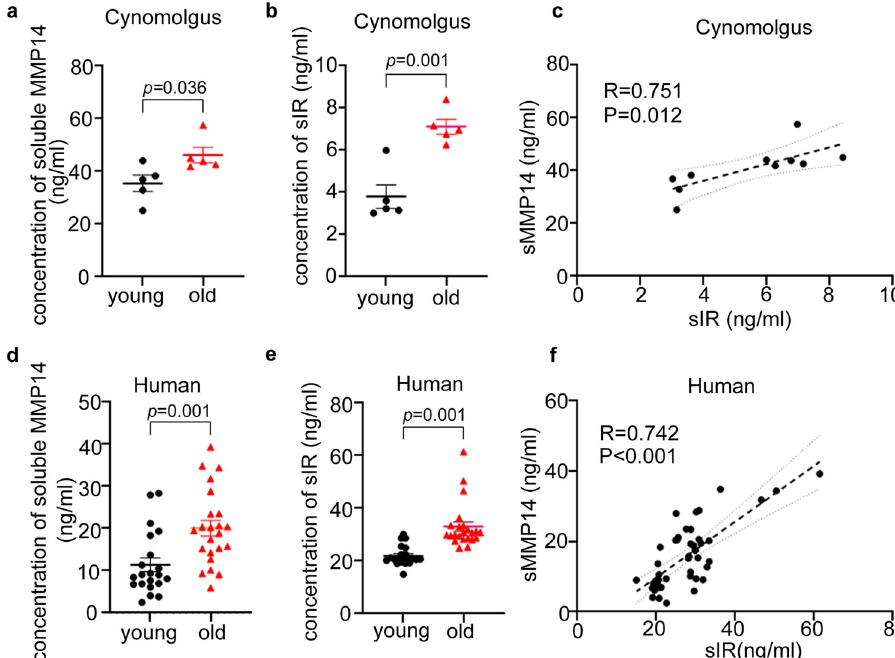
Fig. 6 Elevated level of the soluble insulin receptor in aged primates. a , b , d , e ELISA assay reveals that there is a signi fi cant upregulation of both plasma MMP14 and soluble insulin receptor (sIR) in the plasma of healthily aged cynomolgus macaques ( a , b ) and human subjects ( d , e ) ( n = 5 for non-human primates; 21 young and 23 elderly human subjects; two-sided t test). c , f There is also a positive correlation between plasma MT1-MMP and soluble insulin receptor in the plasma from aged and young non-human primates ( c ) and humans ( f ). (non-human primates: P = 0.012, R = 0.751, n = 10; human: P < 0.001, R = 0.742, n = 44; two-sided Spearman ’ s correlation). Data are reported as average ± s.e.m. Source data are provided as a Source Data fi